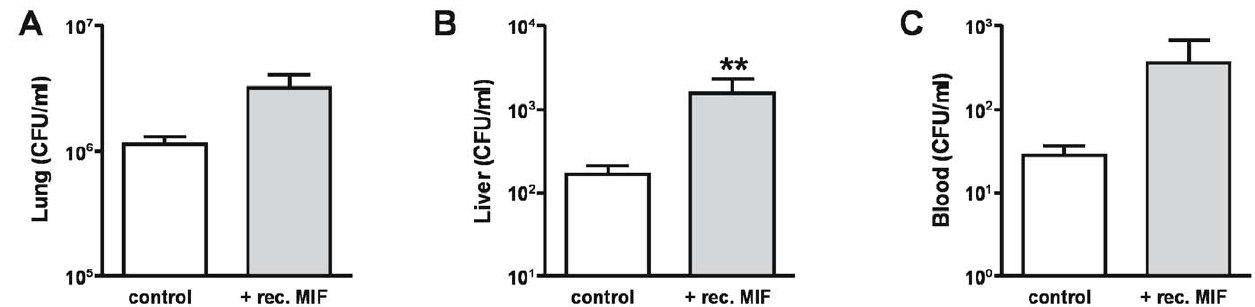
Figure 4. Effect of recombinant MIF on bacterial clearance. Mice, treated with control buffer (white bars) or recombinant MIF (grey bars) and inoculated with 2.5 6 10 2 CFU B. pseudomallei intranasally, were analysed for bacterial outgrowth in the lungs ( A ), liver ( B ) and blood ( C ) 48 hours later. Data represent mean 6 SEM of n=8 mice per group; ** p , 0.01.